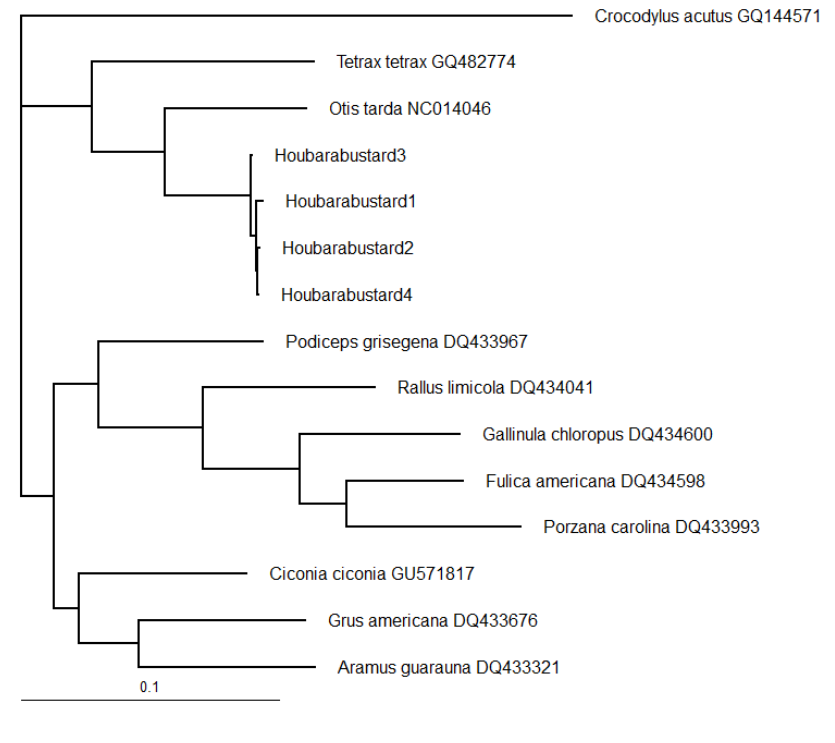
Figure 4. Bayesian tree showing the relationship among 15 different species, including the out group, Crocodylus acutus